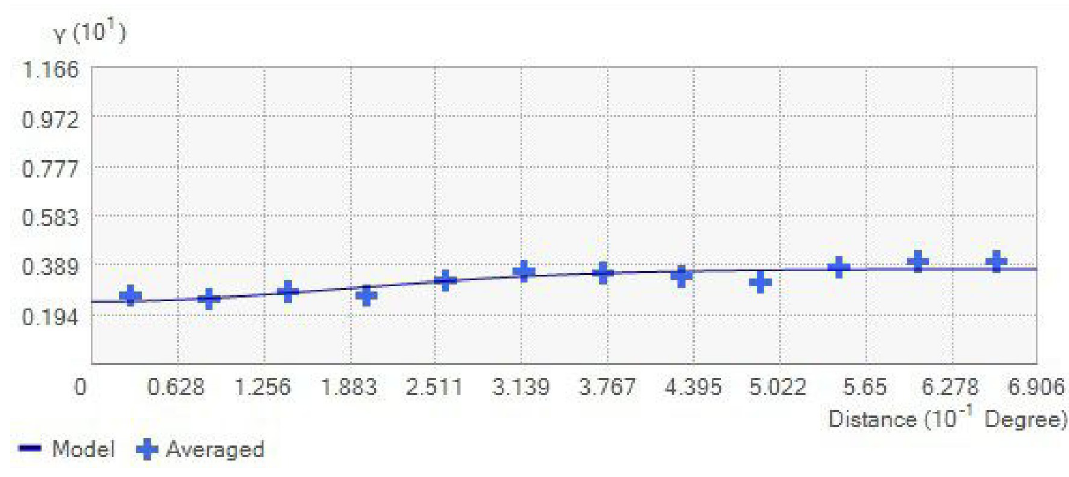
Fig 10. Semi-variogram.